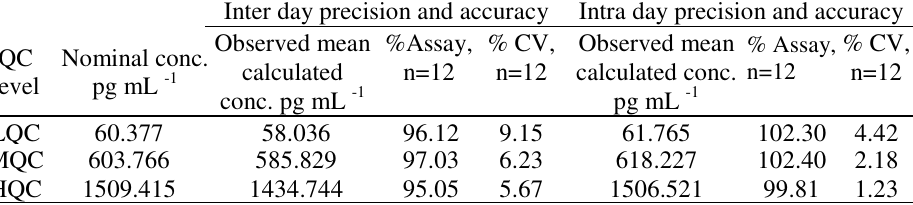
Table 1. Data of inter day and intra day precision and accuracy.